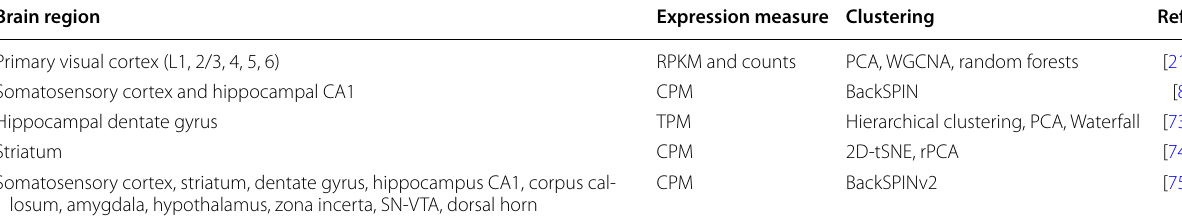
Table 2 Data analysis methods used in recent brain scRNA‑seq